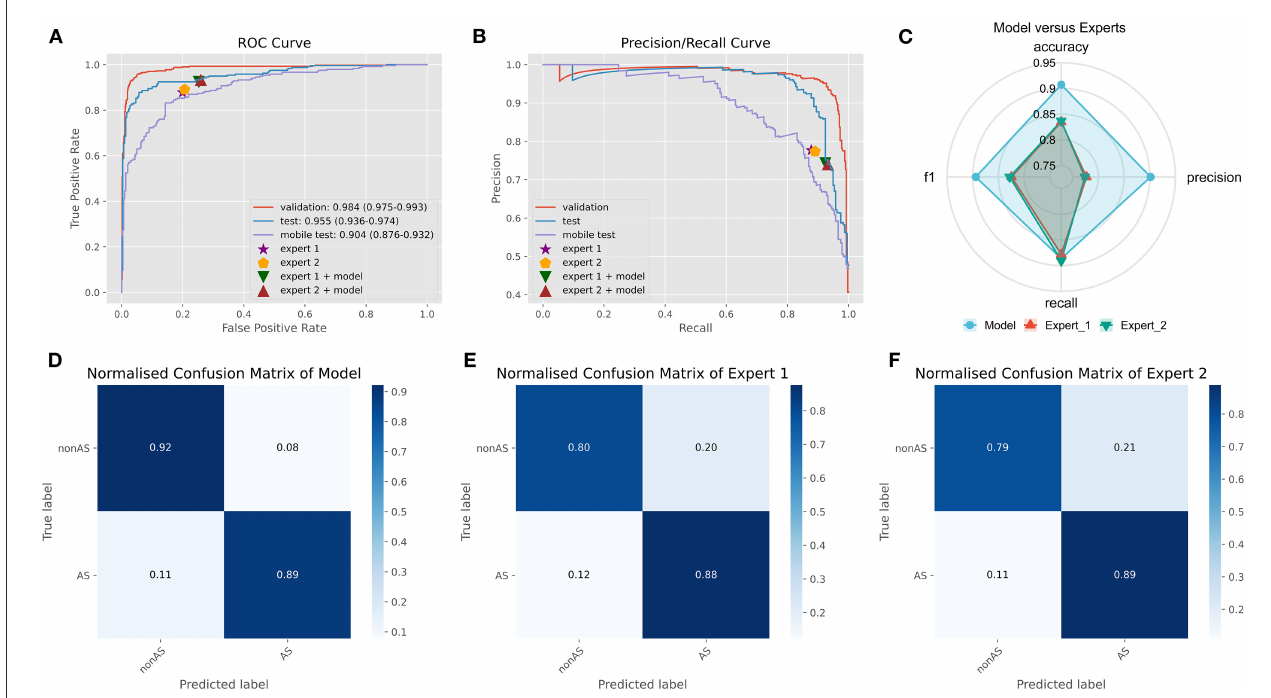
FIGURE2 Comparison of ensemble DL model and human experts. (A) The ROC curve of ensemble DL model in the internal validation dataset, external test dataset, and smartphone-captured images dataset. The performance of two experts with and without model assistance in the external test dataset. (B) The PR curve of ensemble DL model in the internal validation dataset, external test dataset, and smartphone-captured images dataset. The performance of two experts with and without model assistance in the external test dataset. (C) Comparative radar plot of ensemble DL model and human experts in the external test dataset. (D) Normalized confusion matrix of ensemble DL model in the external test dataset. (E) Normalized confusion matrix of expert 1 in the external test dataset. (F) Normalized confusion matrix of expert 2 in the external test dataset.